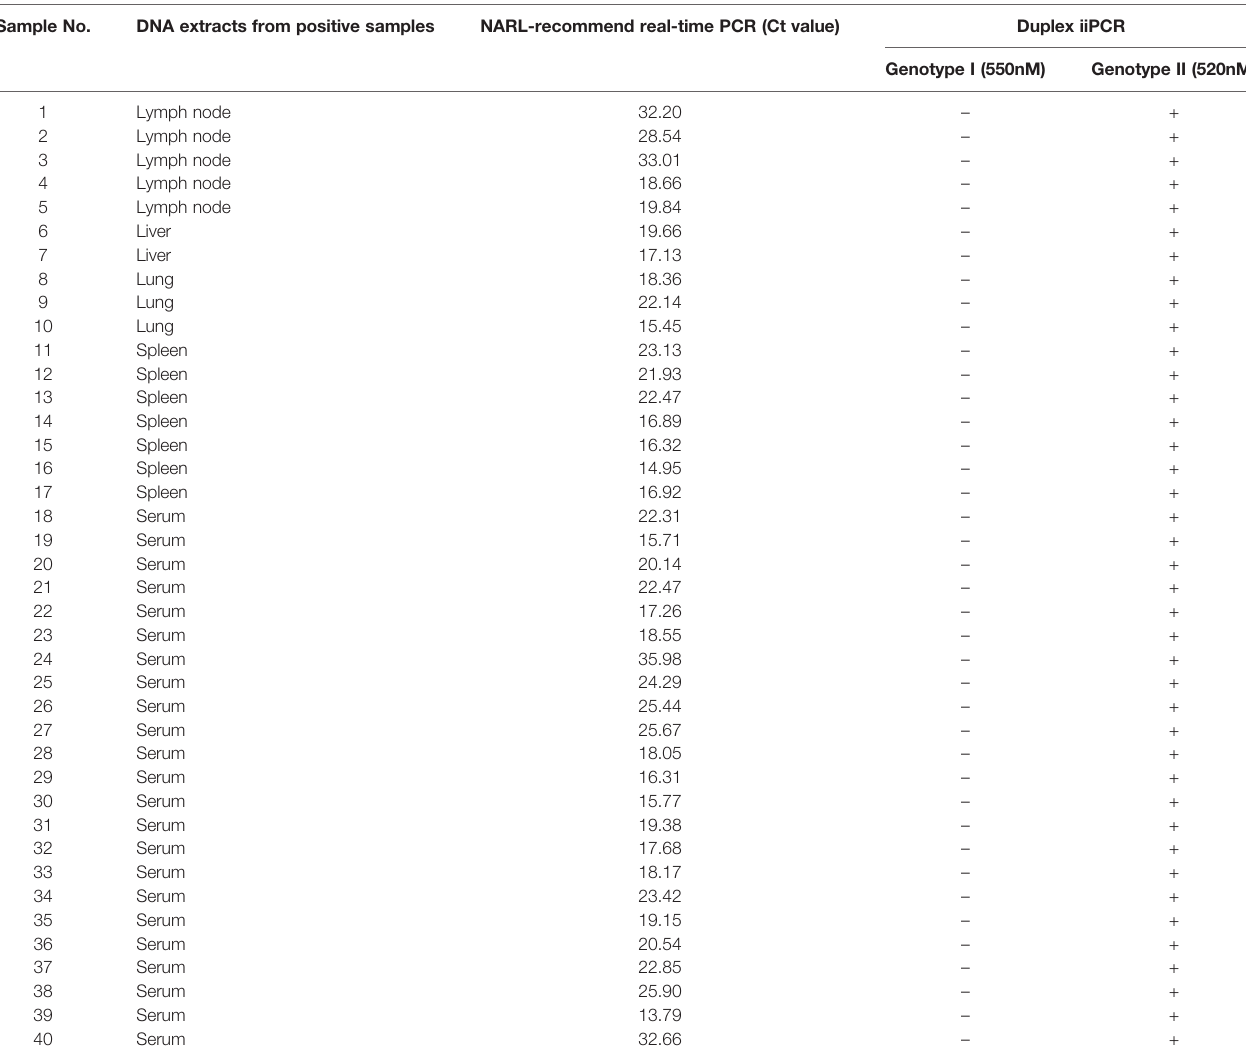
TABLE 4 | Application of the duplex iiPCR on clinical ASFV positive DNA samples. Sample